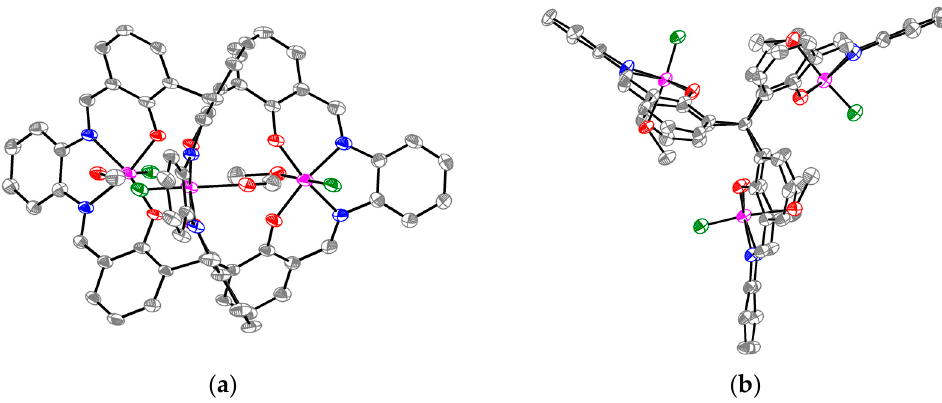
Figure 2. An ORTEP diagram of the single crystal X-ray structure of LAl 3 : ( a ) top view and ( b ) side view. The thermal ellipsoids are scaled to the 50% probability level. Carbon atoms are depicted in grey, oxygen in red, nitrogen in blue, fluorine in green, and aluminum in pink.